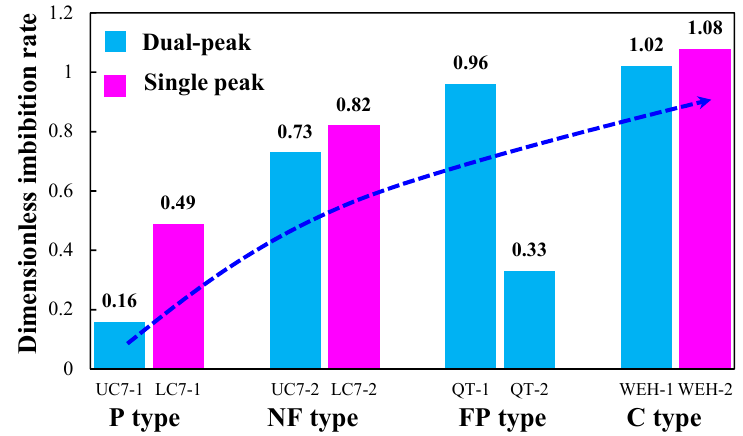
ff erent reservoirs